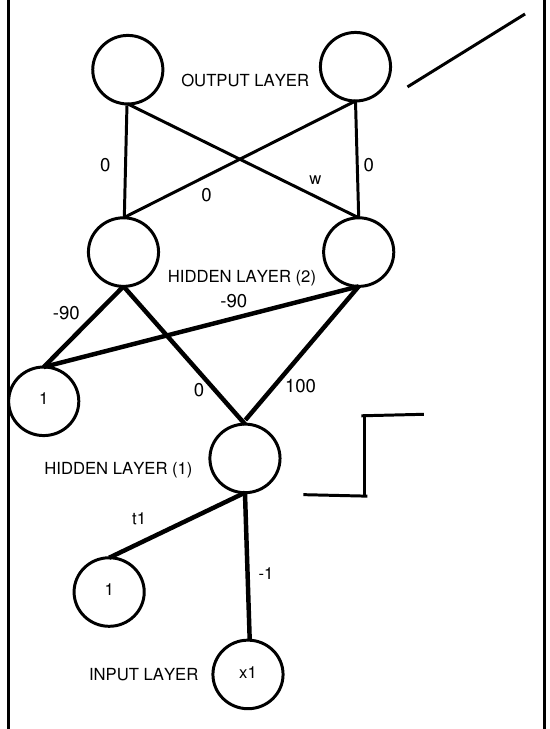
Figure 5. An MLP with two hidden layers that represents a propositional rule with a unique antecedent ( x 1 ≤ t 1 ) . The activation function of the output layer is the identity, with coefficient w representing the rule